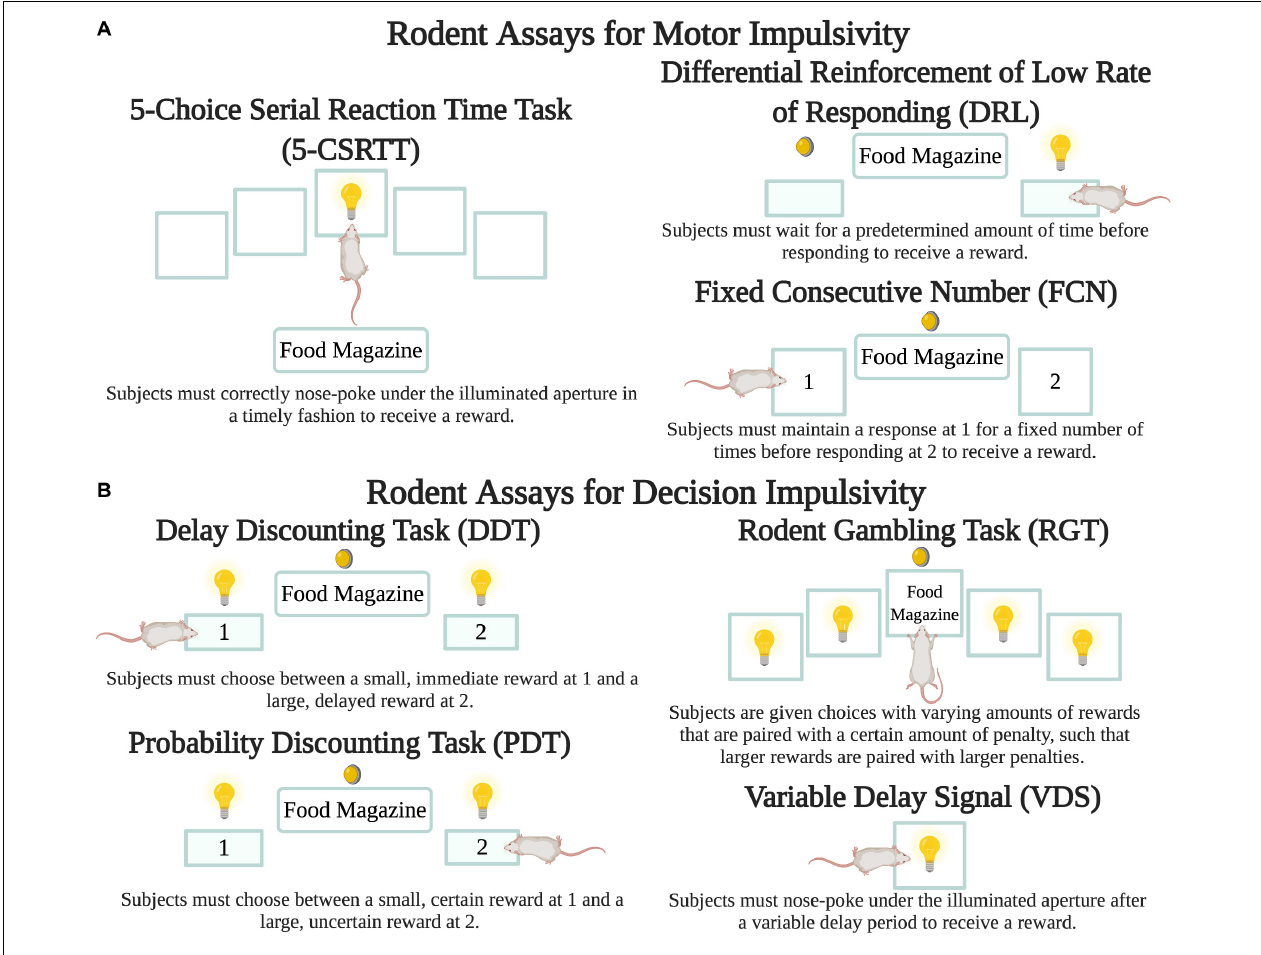
FIGURE 2 | Rodent assays to measure impulsivity. While there are a number of variants for each protocol, the figure depicts the basic details of each. Lightbulbs are cue lights, circular lights are house lights, filled-in rectangles are pressable levers, and transparent squares are apertures for nose pokes. (A) Motor impulsivity can be measured through the 5-CSRTT (Higgins and Silenieks, 2017) as well as the DRL and FCN schedules (Engeln et al., 2016). (B) Decision impulsivity can be measured through the DDT (Tedford et al., 2015), PDT (Rokosik and Napier, 2012), and RGT (Tremblay et al., 2019). VDS can measure both motor and decision impulsivity (Jiménez-Urbieta et al., 2020). Created with